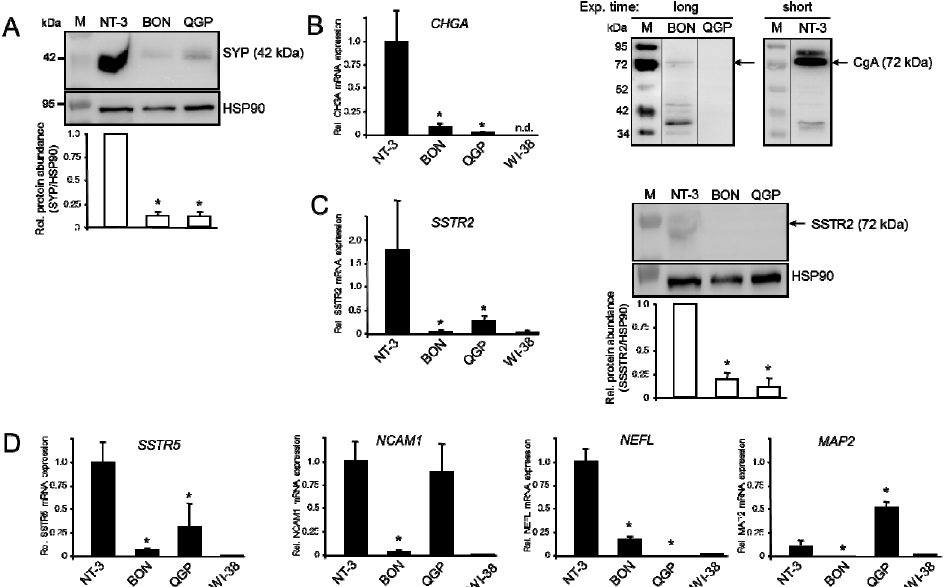
Figure 1. Expression of markers of neuroendocrine differentiation in BON and QGP cells, and NT-3 cells as control. ( A ) Immunoblot analysis of synaptophysin (SYP), and heat shock protein 90 (HSP90) as a loading control, in NT-3, BON, and QGP cells. The graph underneath the blot depicts the relative (Rel.) protein abundance calculated from the densitometric readings of band intensities (mean ± SD, n = 3) from three independent experiments, relative to NT-3 set arbitrarily at 1.0. The numbers to the left indicate band sizes of the molecular weight marker (M). ( B ) Quantitative real-